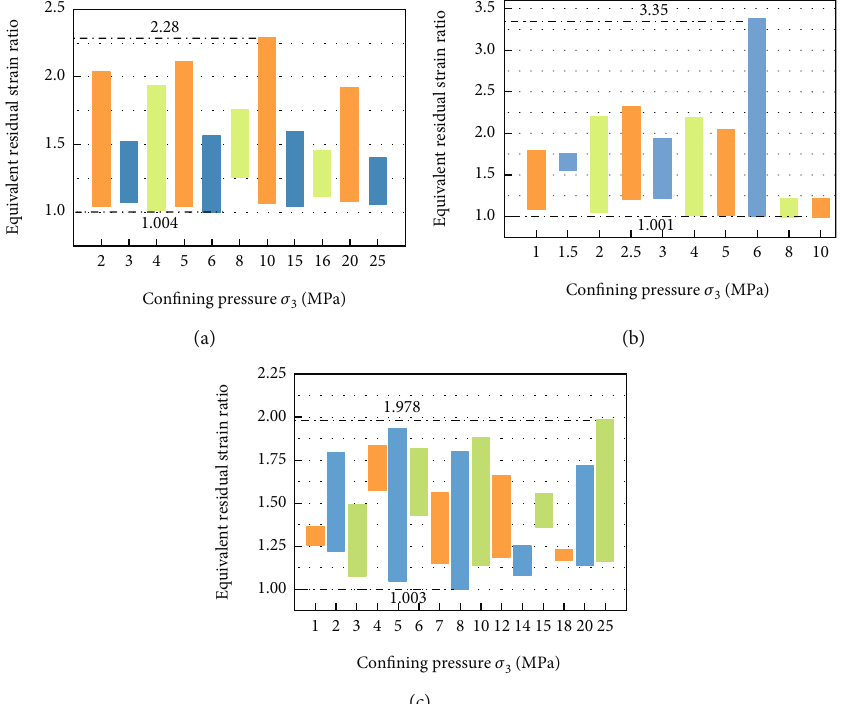
Figure 10: Suspension bar diagram of equivalent residual strain ratio: (a) raw coal, (b) briquette composed of soft coal, and (c) soft